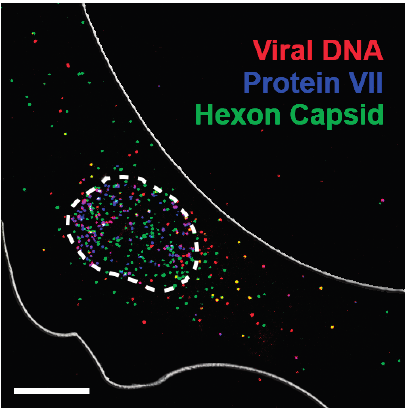
Figure 1. Misdelivery of capsid-free adenovirus DNA after uncoating at the nuclear pore complex. Wang et al. [53] infected HeLa cells for 150 minutes followed by fixation and viral genome click-labeling using Alexa Fluor 594 (red). Shown is a total projection of confocal optical slices depicting immune-stained protein VII (blue) and hexon capsid (green). Viral genomes associated with protein VII appear as purple dots in the nucleus, whereas partially uncoated cytosolic virus particles containing viral DNA (vDNA) appear as yellow dots. It is thought that protein VII remains attached to incoming vDNA during translocation into the nucleus, but copy number per genome is uncertain, as well as if any other viral proteins, such as terminal protein or protein X remain associated during import [58–60]. Analyses revealed that a large pool of viral DNA does not reach the nucleus during infection, but rather accumulates capsid-free in the cytosol of the host cell. The borders (white) were identified using DAPI for the nucleus and contrast-enhanced protein VII for the cell membrane. Scale bar, 10